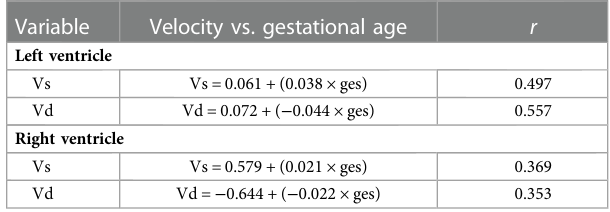
TABLE 2 Regression equation of relationship between peak global velocities of left and right ventricular myocardium and gestational age in normal fetuses .